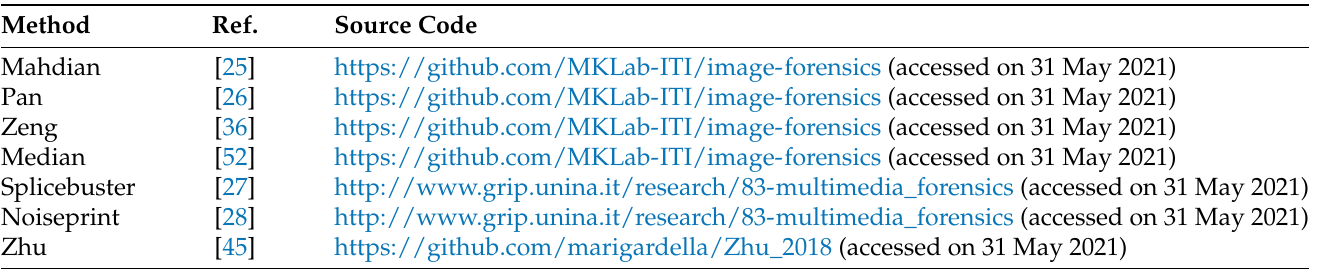
Table 3. State-of-the-art methods used for the comparison as well as their reference and link to source code. Method